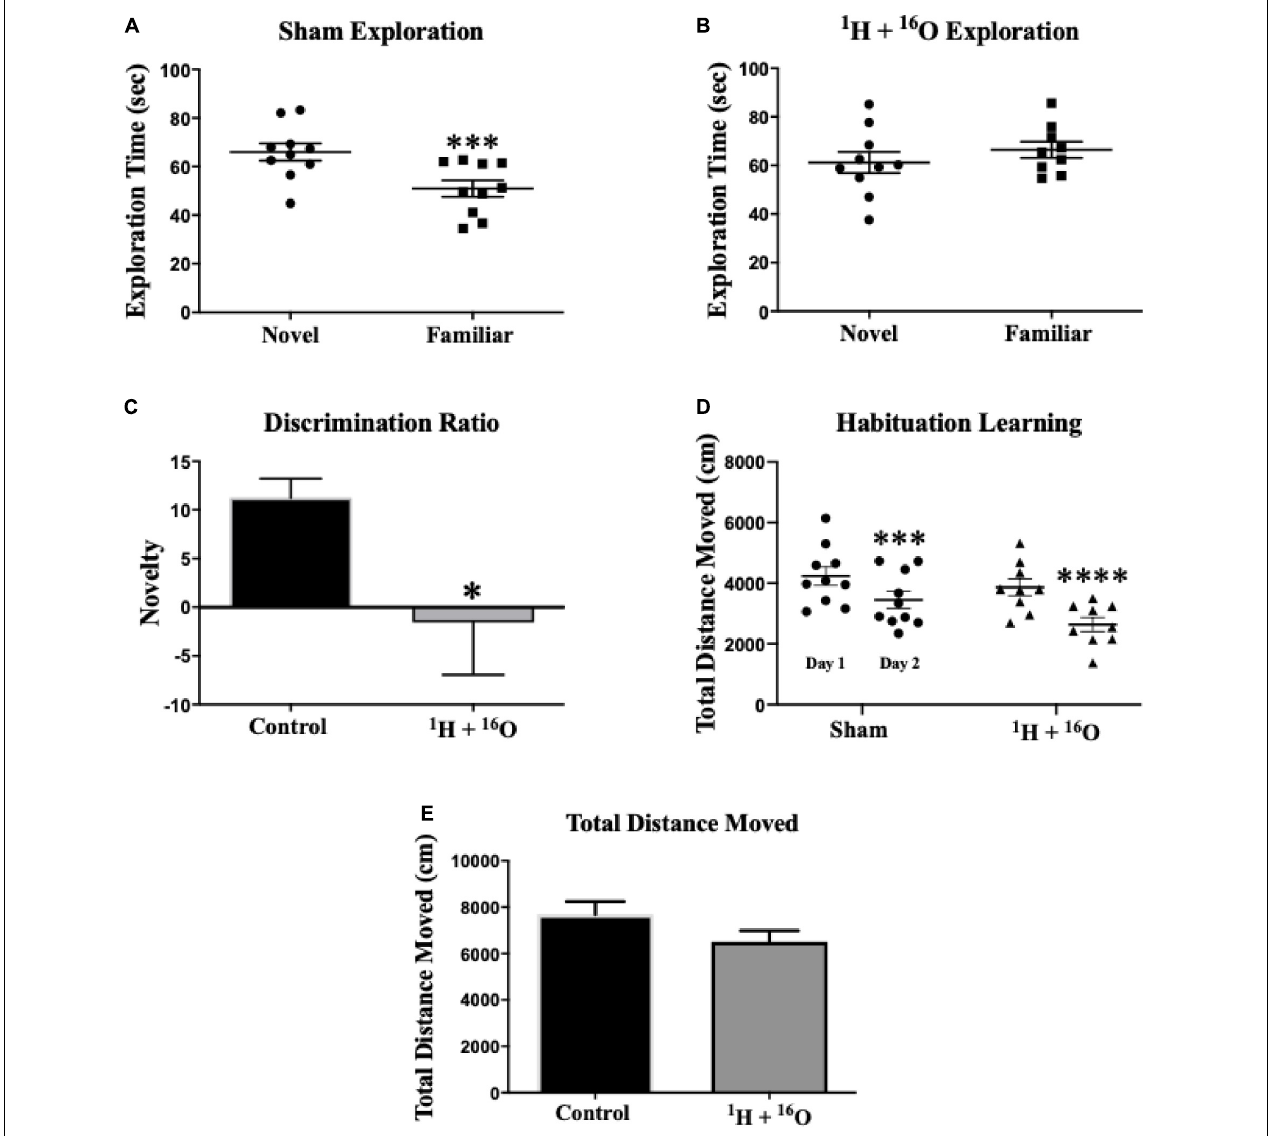
FIGURE 2 | Novel object recognition. (A) Sham-irradiated animals spent more time exploring the novel object than the familiar one. (B) Radiated animals spent approximately equal time exploring both the novel and familiar objects during testing, indicating an inability to remember the familiar object. (C) Animals who received radiation show profoundly low object discrimination relative to sham-irradiated animals. (D) Sham and irradiated mice displayed normal habituation to the empty testing arena, by attenuating cumulative exploration across both habituation days. (E) Locomotor activity was similar across radiation groups on testing day. Average ± SEM ( n = 10); * P < 0.05, *** P < 0.001, **** P <